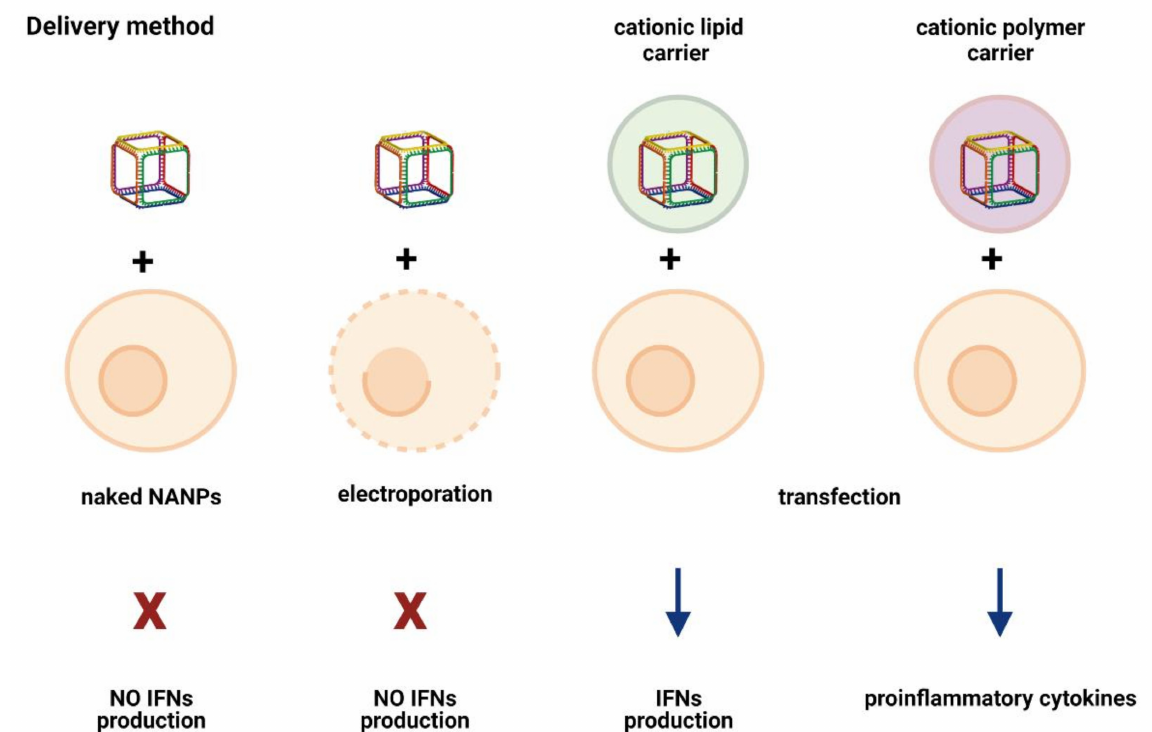
Figure 3. Delivery method and type of carrier affects cellular immune response. Naked NANPs do not trigger IFN response even upon transport to the cytosol via electroporation. Cellular defense is activated by NANPs only if they are in complex with carrier. The type of delivery carrier determines the spectrum of cytokines produced in response to